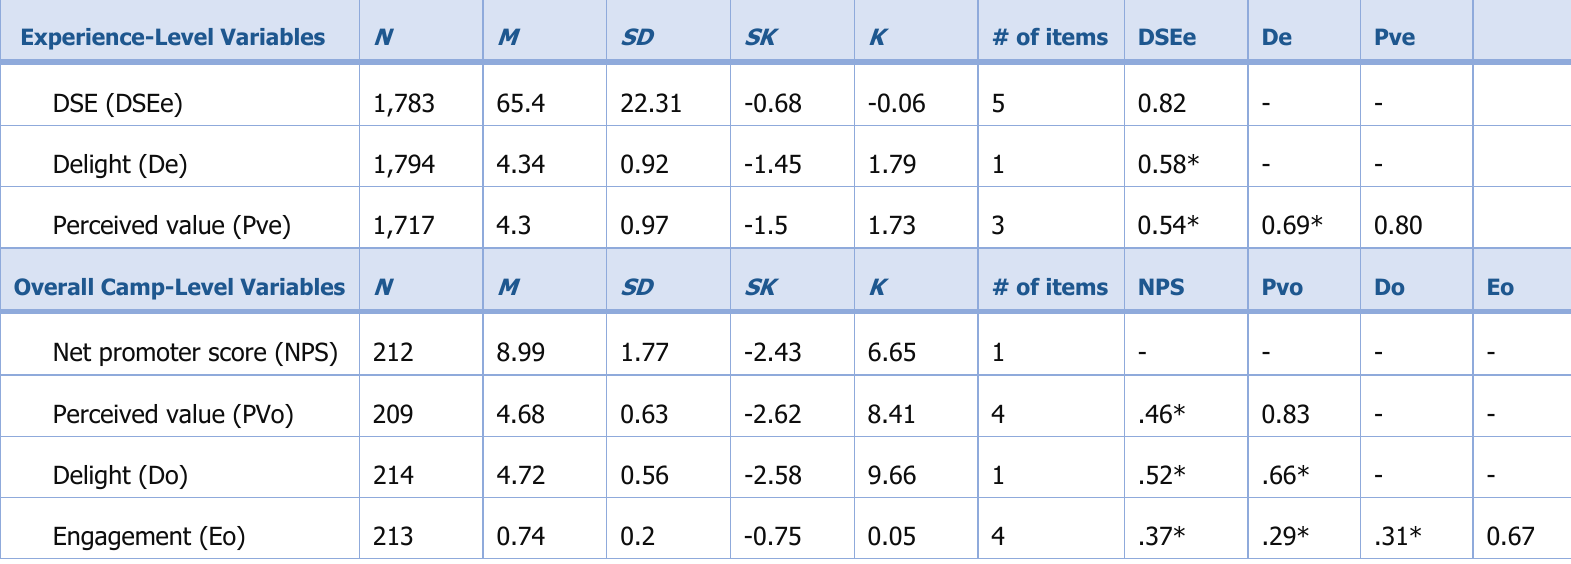
Table 1. Descriptive Statistics for Experience and Camp-Level